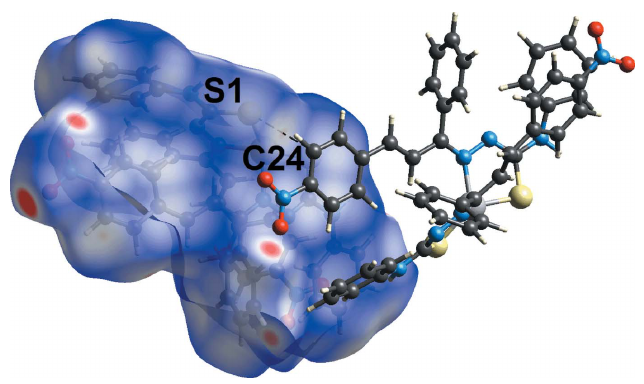
Table 3. The (cid:2) (C23–C28)– (cid:2) (Zn,S2,N5,N6,C38) and nitro- O1 (cid:3) (cid:3) (cid:3) (cid:2) (C23–C28) interactions were not manifested on the d -mapped Hirshfeld surface. However, the (cid:2) – (cid:2) inter- norm action appears as a flat surface on the curvedness-mapped Hirshfeld surface of Fig. 8( a ), the nitro-O (cid:3) (cid:3) (cid:3) (cid:2) interaction is shown as red concave and blue bump regions on the shape- -mapped Hirshfeld norm index-mapped Hirshfeld surface of Fig. 8( b ).